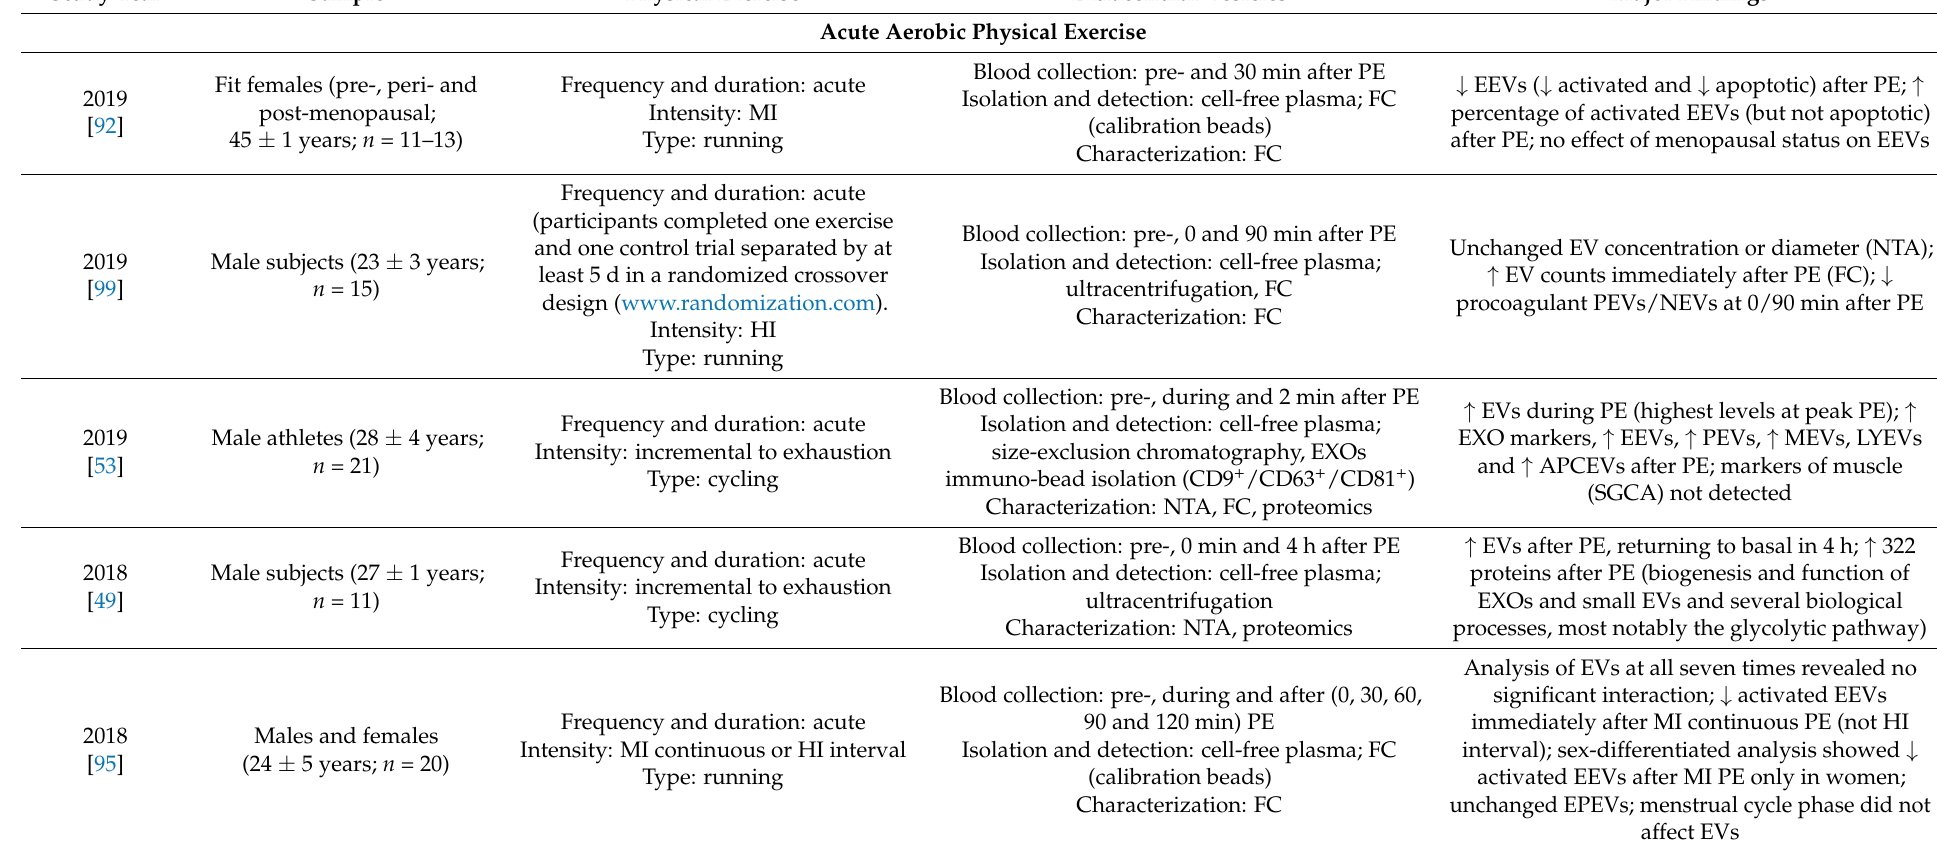
Table 2. Acute and chronic aerobic physical exercise effects on circulating extracellular